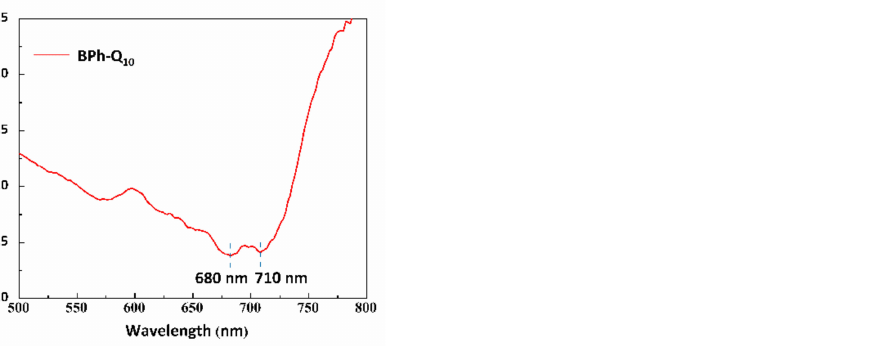
Figure 5. FTIR spectra of ( a ) BPh-Q 10 prepolymer ( b ) BPh-Q 30 prepolymer. The FTIR spectra are recorded between 4000 and 400 cm − 1 in air.